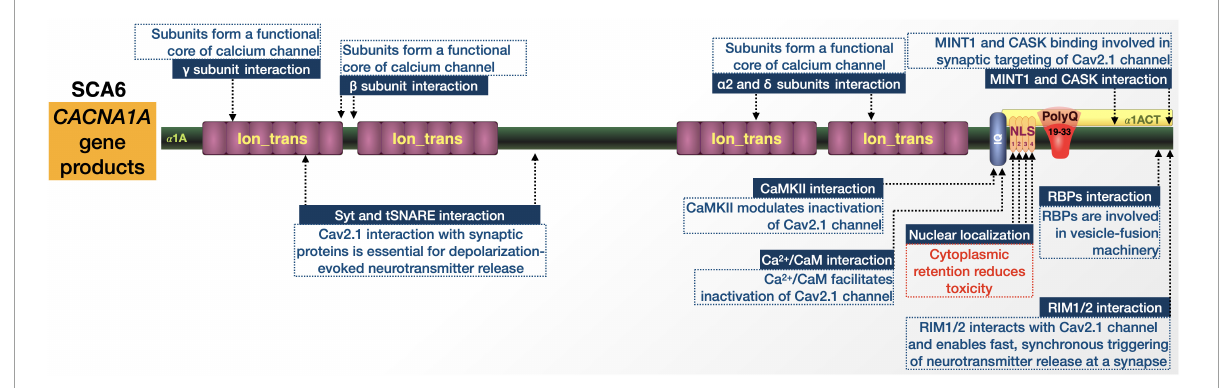
FIGURE8 Graphic representation of the SCA6 proteins, domains, and interactions. Details are in the main